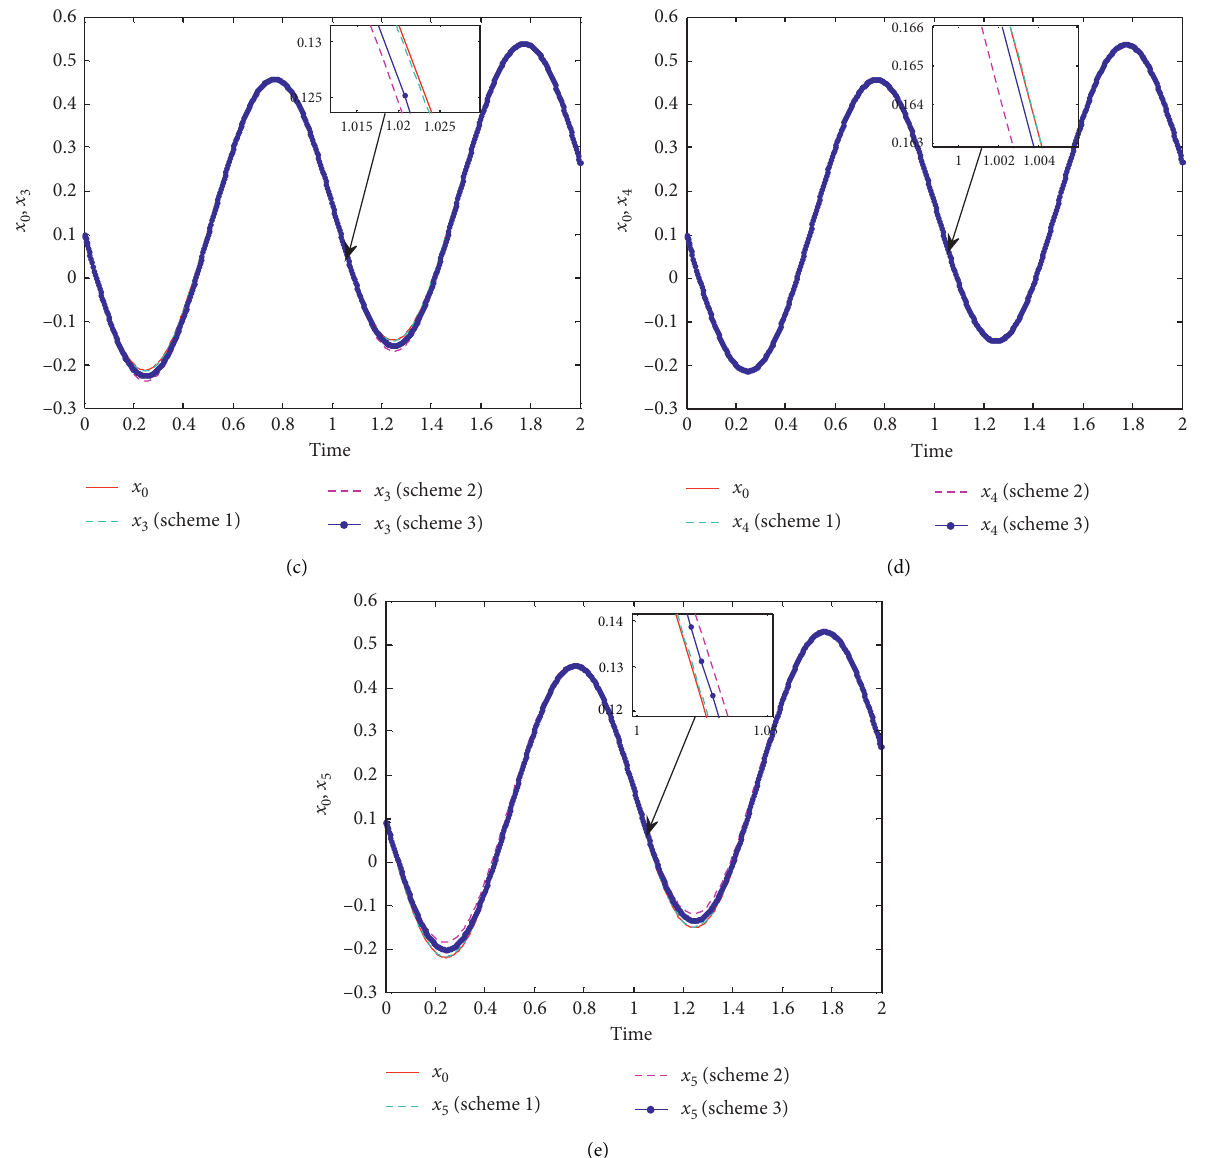
Figure 5: Comparison results with other approaches. (a), (b), (c), (d), and